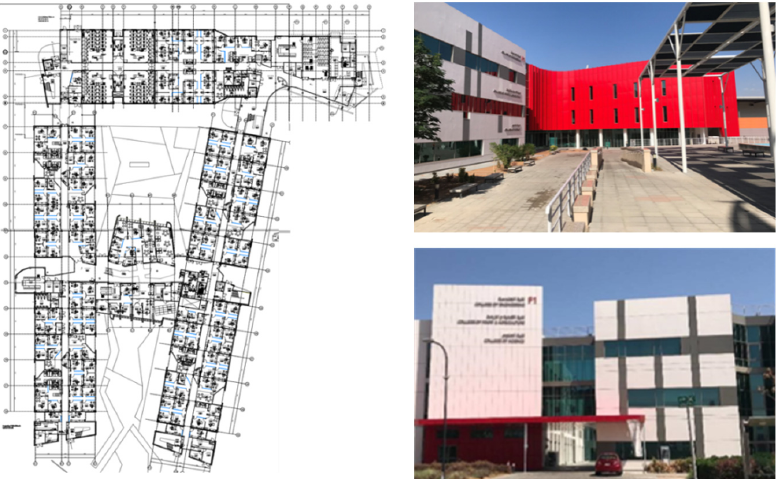
Figure 2. Case study building, floor plan, and photos. Table 3. Case study building